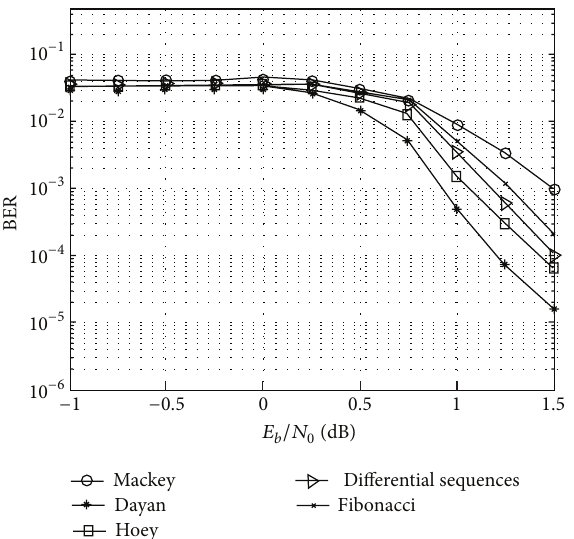
Figure 5: The BER performance comparison curve of QC-LDPC constructed by four different integer sequences and Mackey code in the code cooperative communication